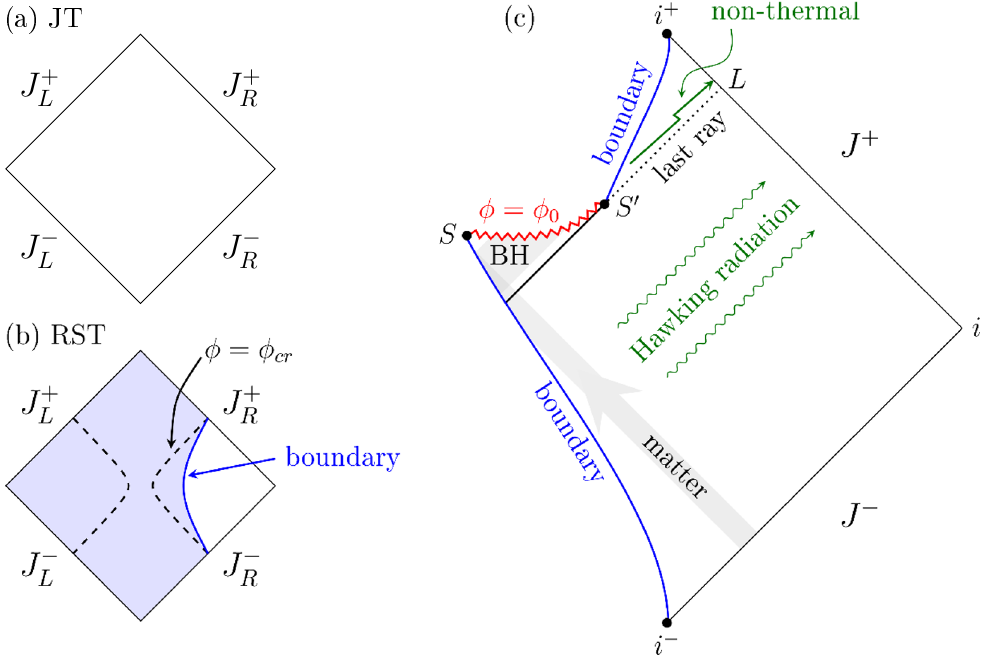
Figure 1 . (a), (b) Causal structures of (cid:13)at-space JT model and RST model. (c) Penrose diagram for the evaporating RST black